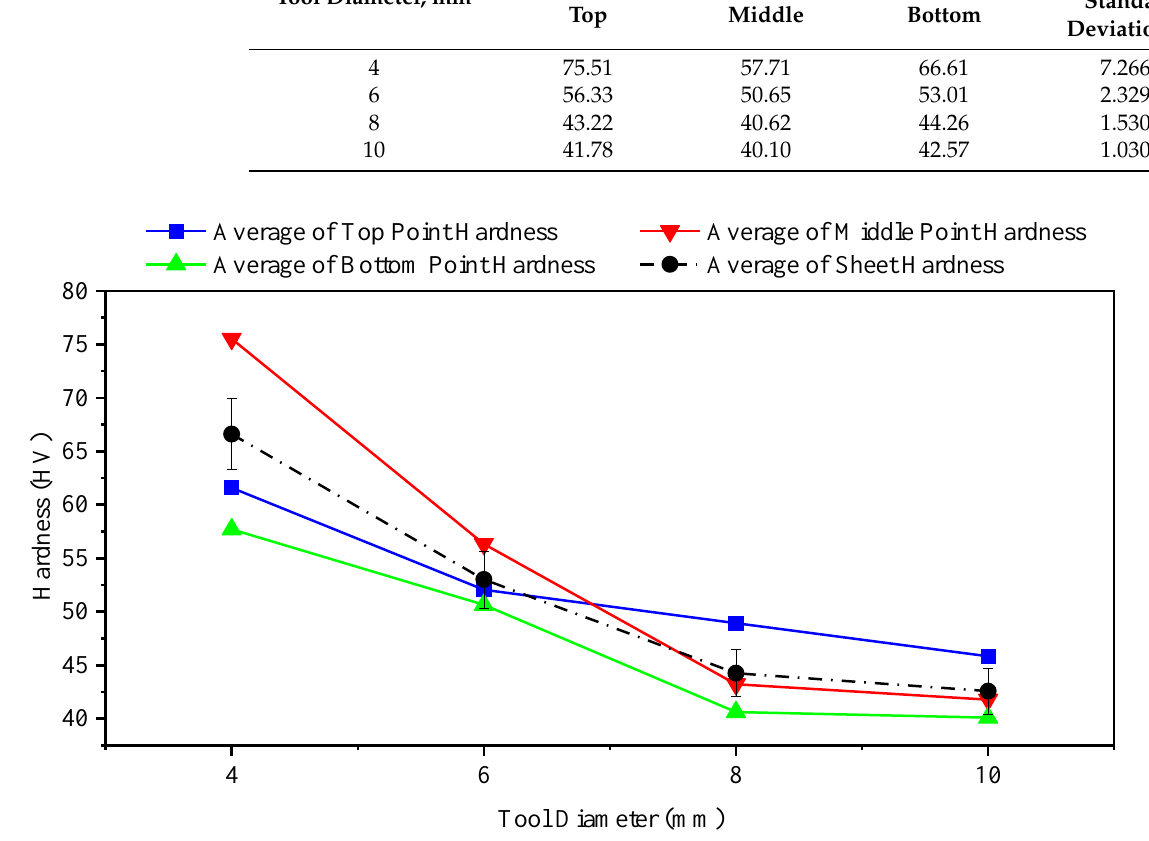
Table 7. Effects of different tool diameters on hardness . Tool Diameter, mm